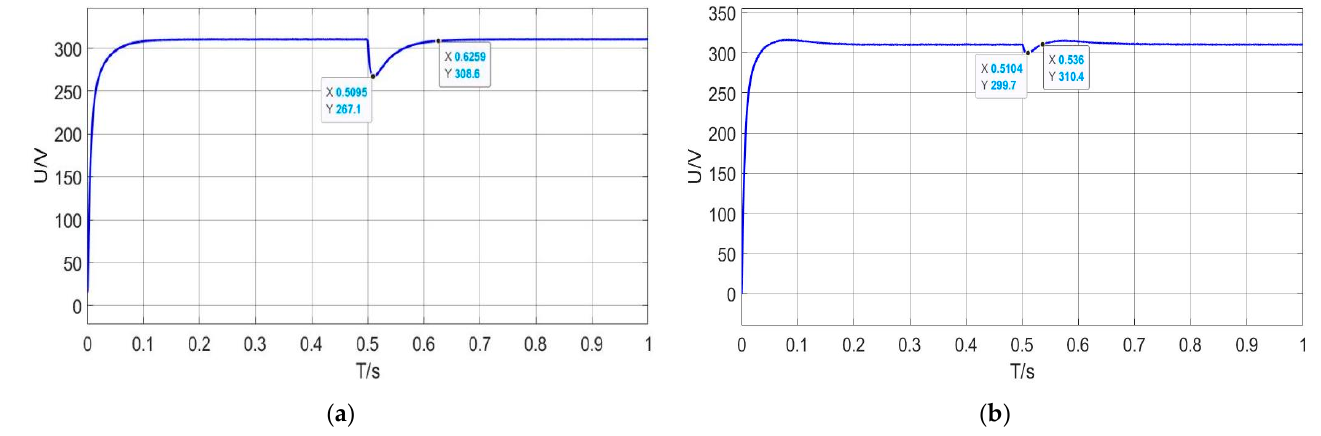
Figure 11. Critical load voltage curve. ( a ) With v/F control. ( b ) With electric spring control.